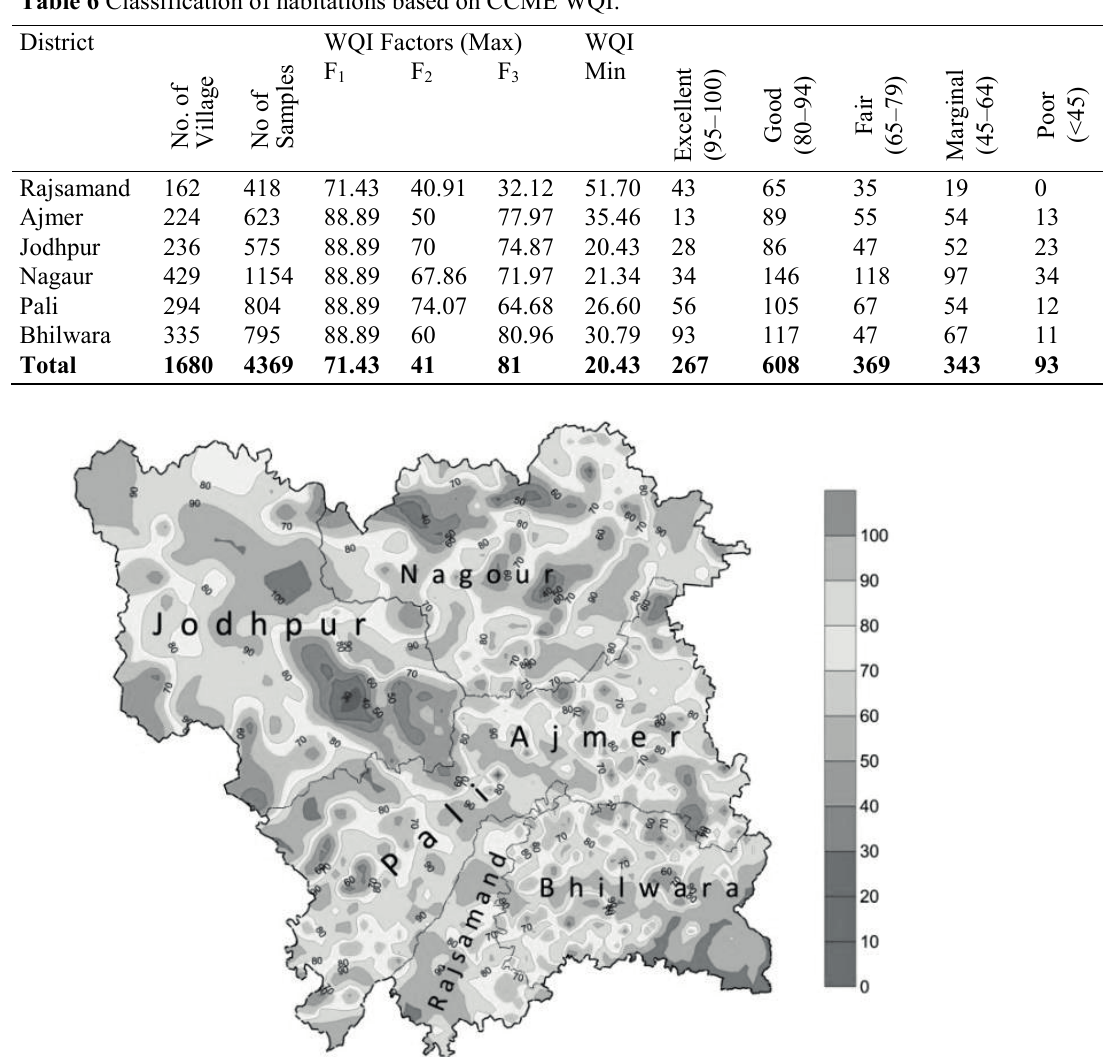
Fig. 2 Contour map for study